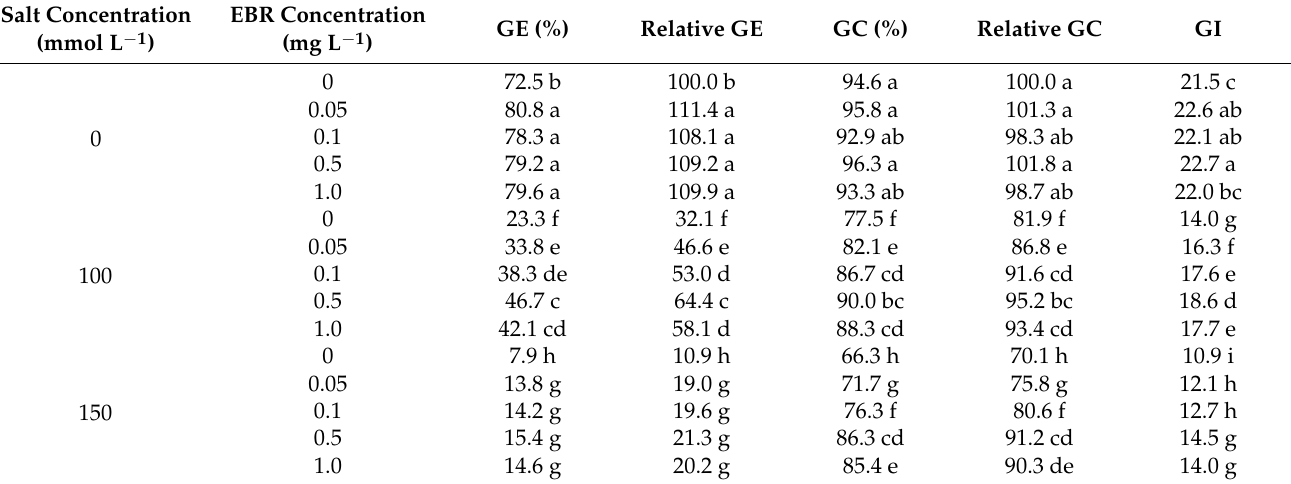
Table 2. Rice seed germination indicators.